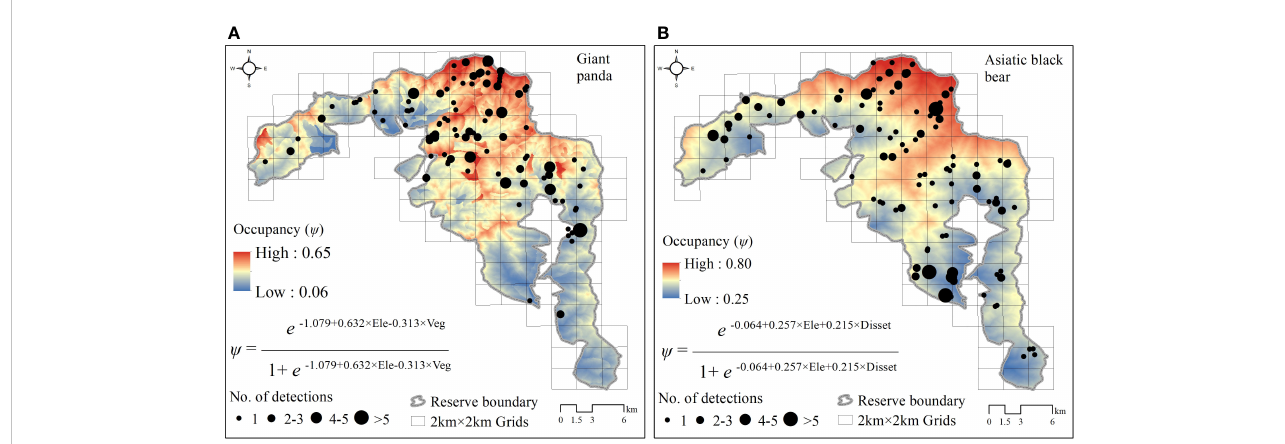
FIGURE 2 Spatial projection of giant panda (A) and Asiatic black bear (B) occupancy probability and model structure in Changqing National Nature Reserve, based on the optimal models ( D AIC ≤ 2). Black points show the location of giant pandas and Asiatic black bears detected by camera traps, and their size indicates the number of independent detections. Ele, elevation; Veg, understory vegetation type; Disset, distance to nearest